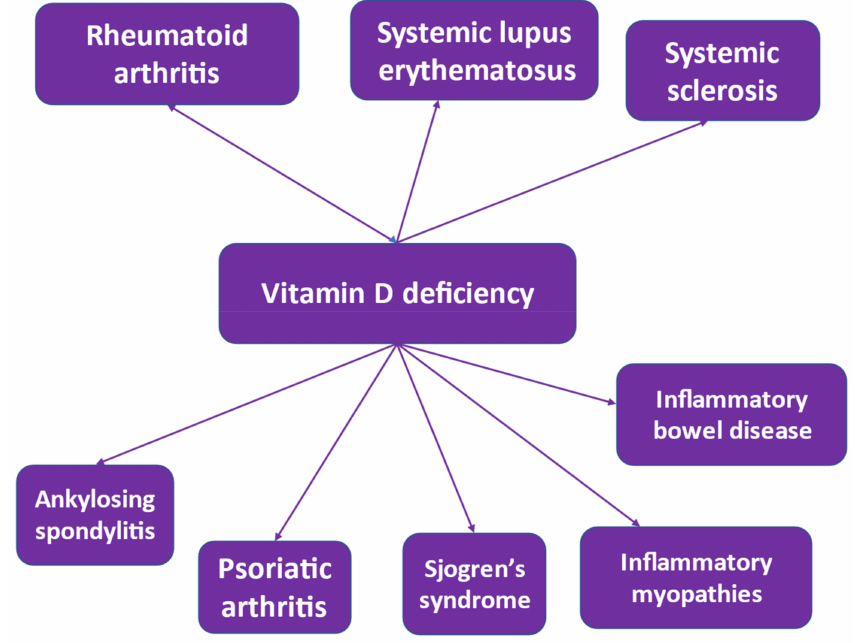
Figure 1. Autoimmune rheumatic diseases related to vitamin D